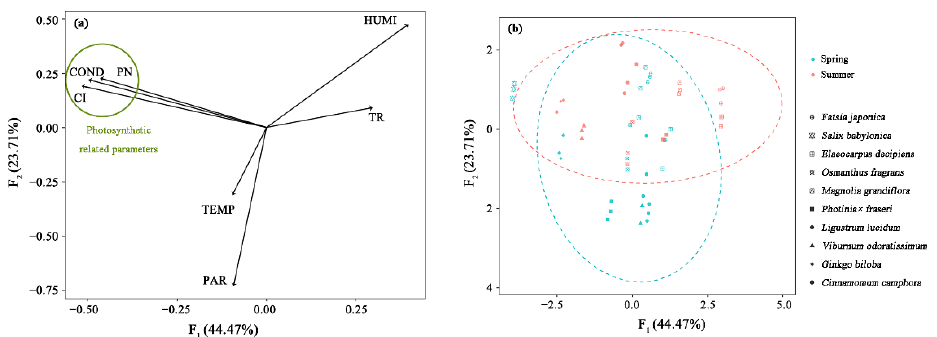
Figure 5. Principal component analysis of the 7 parameters. ( a ) Representation of the correlation coefficient between the principal components and the parameters. ( b ) Representation of the emis- sion rate of 10 tree species in two seasons. F 1 = the first principal component; F 2 = the second principal component.